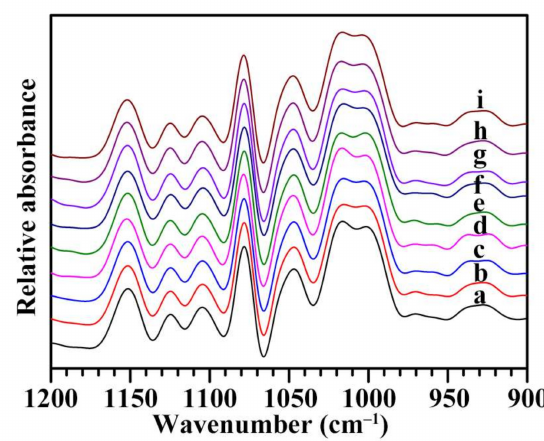
Figure 4. ATR-FTIR spectra of starches from variety 3113 ( a ), Benlizi ( b ), Dahongpao ( c ), Erqingzao ( d ), Heishanzhai 7 ( e ), Mi 5 ( f ), Mi 6 ( g ), Yangguang ( h ), and Yanshanhong ( i